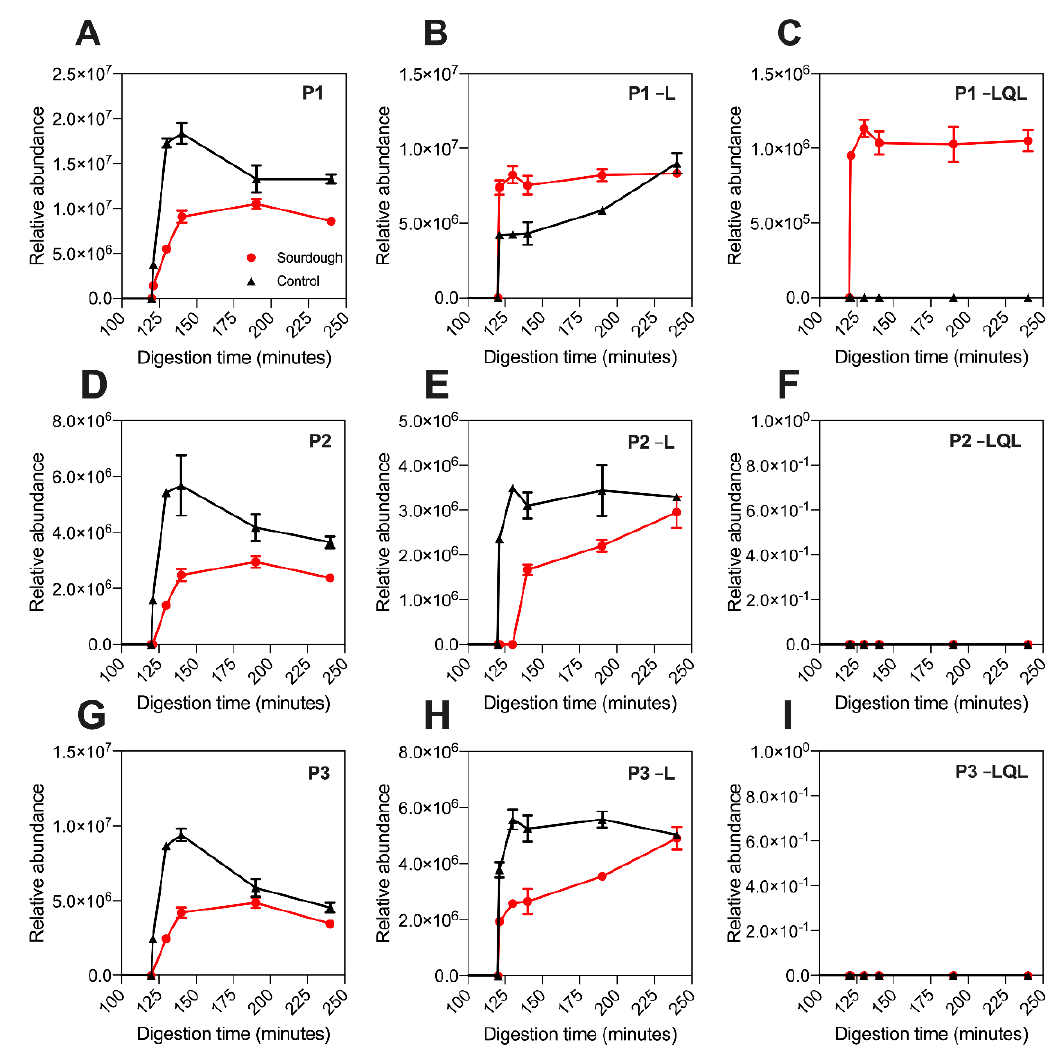
Figure 3. The release profile and relative abundance of the proteolytic products deriving from peptides P1, P2, and P3 throughout the digestion of sourdough (red) and the control (black) breads. Relative abundance determined by untargeted LC–MS. Release profile of ( A ) peptide P1, ( B ) P1-L proteolytic product, ( C ) P1-LQL proteolytic product, ( D ) peptide P2, ( E ) P2-L proteolytic product, ( F ) P2-LQL proteolytic product, ( G ) peptide P3, ( H ) P3-L proteolytic product, and ( I ) P3-LQL proteolytic product. L represents leucine and LQL represents a Leu-Gln-Leu tripeptide. All samples were digested and analysed in triplicate. Error bars display the standard deviation of the